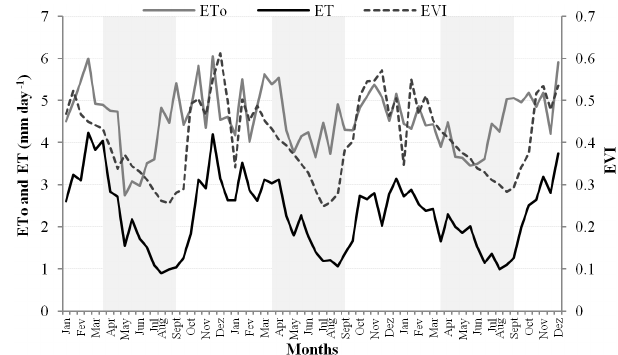
Figure 2. Seasonality of enhanced vegetation index (EVI), refer- ence evapotranspiration (ETo) and observed actual evapotranspira- tion (ET) data from 2001 to 2003 at the PDG site. The grey shaded bars show the dry